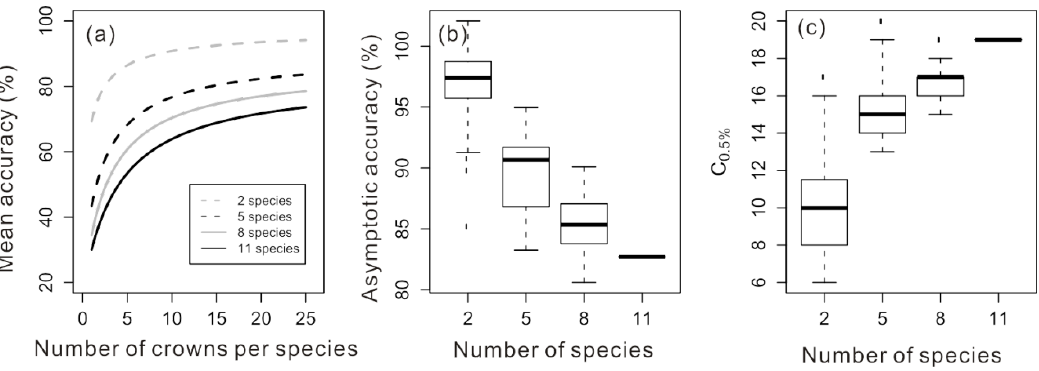
Figure 5. Results from accuracy curves constructed from classifications of different numbers of species. ( a ) The average accuracy curve for each set of 55 accuracy curves made from classifications of 2, 5 or 8 species, alongside the accuracy curve for the full 11 species model (same as Figure 1b); ( b ) Box-and-whisker plots of the asymptotic accuracy values obtained for the accuracy curves constructed from classifications and ( c ) C 0.5% of 2, 5, and 8 species and the value calculated for the full 11 species model.